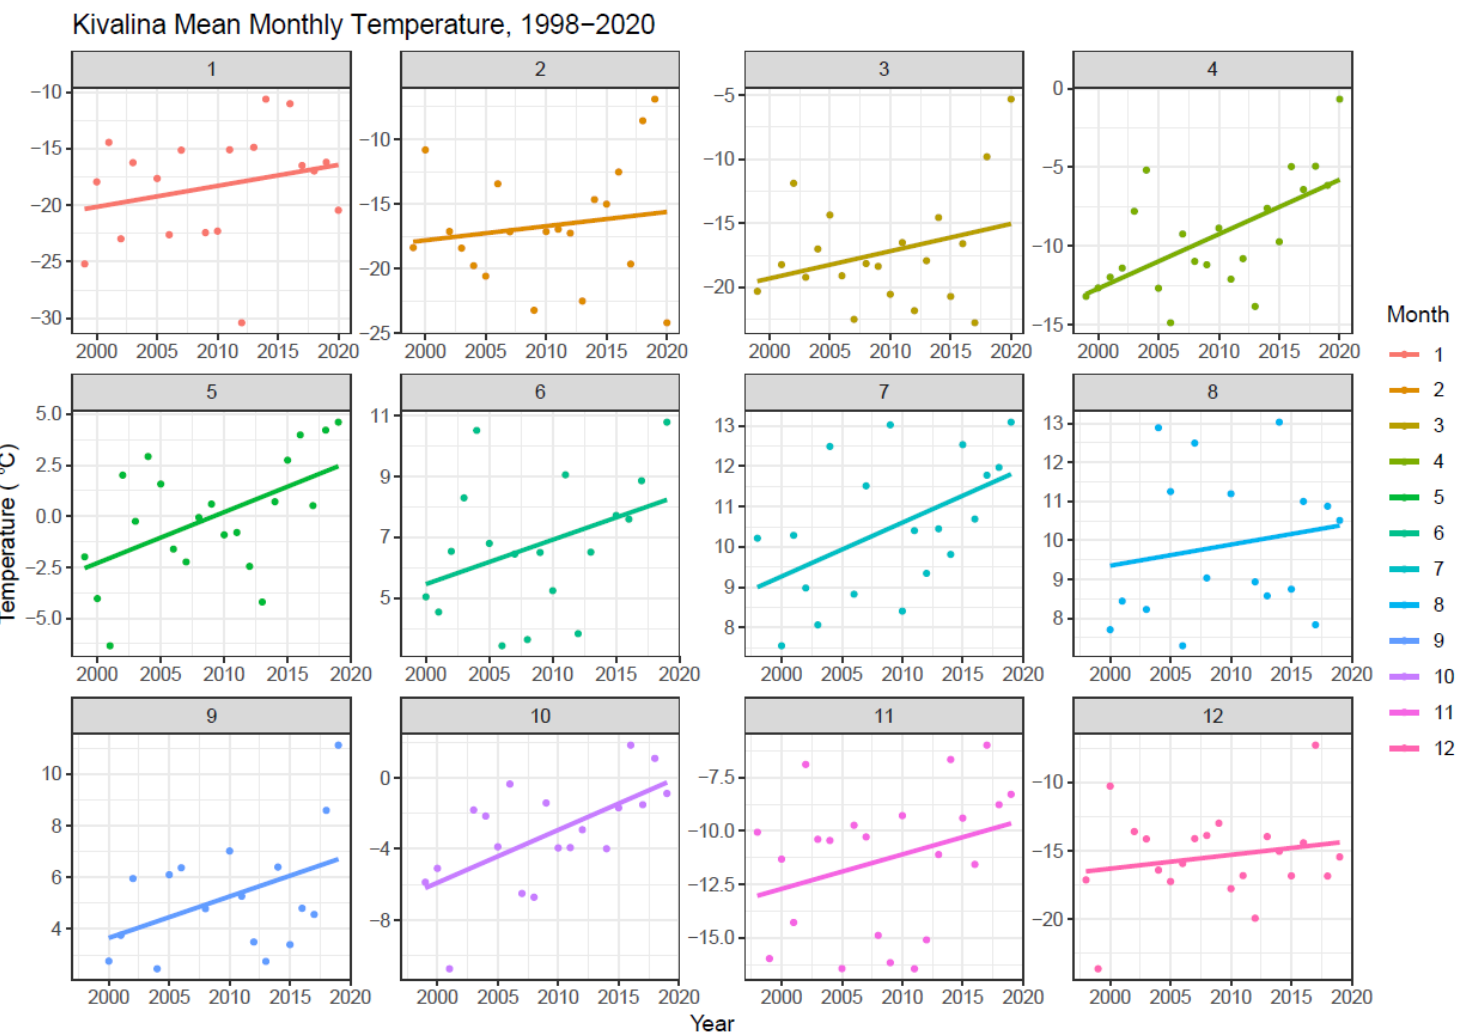
Figure A2 . 2 Trends in air temperature in Kivalina, Alaska, from 1998 to 2020. Points are the average of daily temperature values for each month. Lines are predicted values from linear regression models fitted to the data (see Table A2.2). Data source: NOAA National Center for Environmental